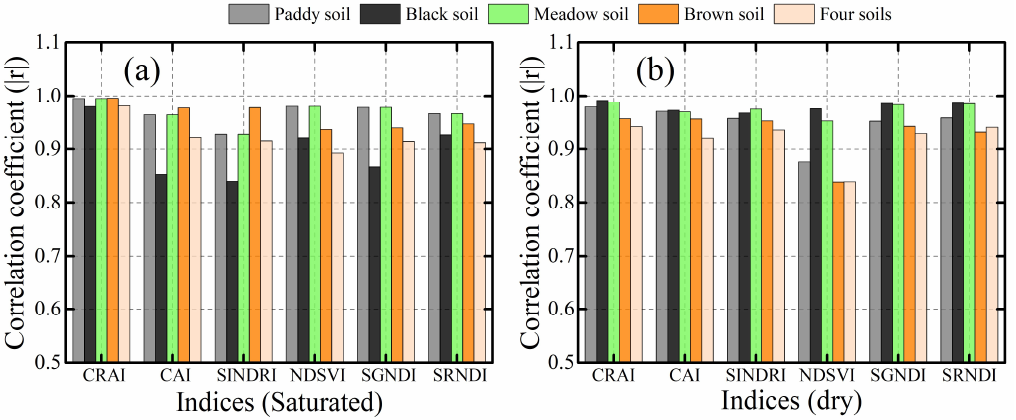
Figure 9. Absolute value (|r|) of correlation coefficient between: (i) CRC and (ii) CRAI, CAI, SINDRI, NDSVI, SGNDI, and SRNDI for saturated ( a ) and dry ( b ) datasets (see legend).